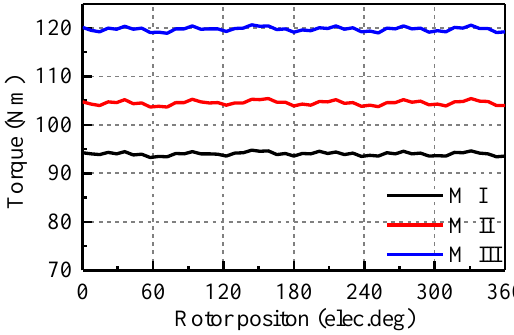
Figure 8. Output torque waveforms of the machines at rated load condition.